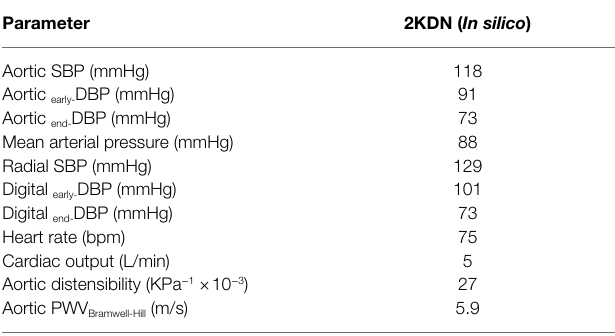
TABLE 2 | Distensibility of default values ( in silico ) versus distensibility of end- stage renal disease (ESRD; in vivo ). Arterial